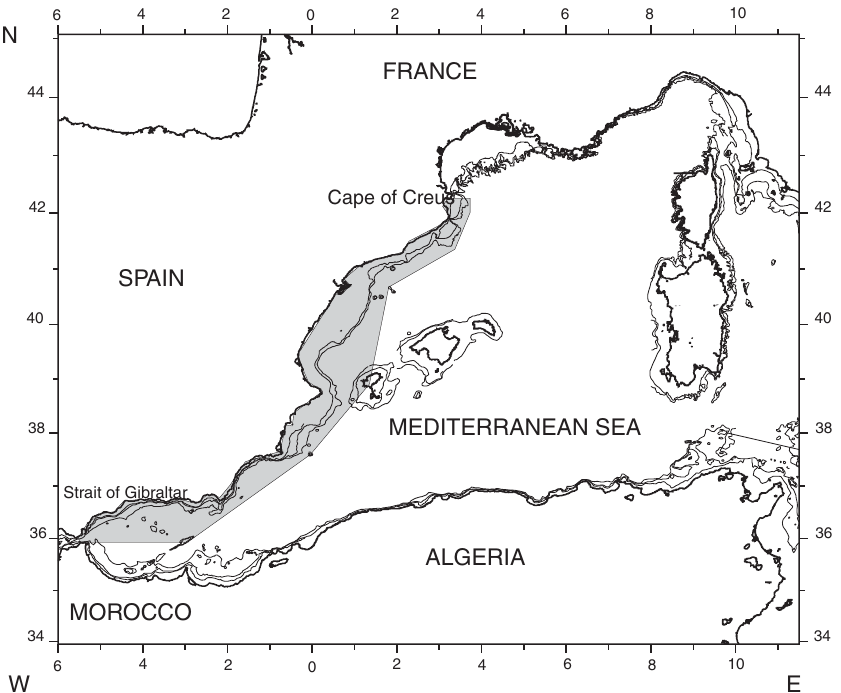
F IG . 1. – Map of the Western Mediterranean illustrating the study